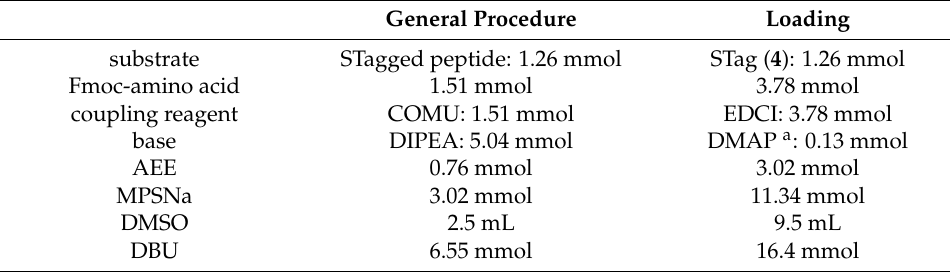
Table 5. Conditions of general procedure and